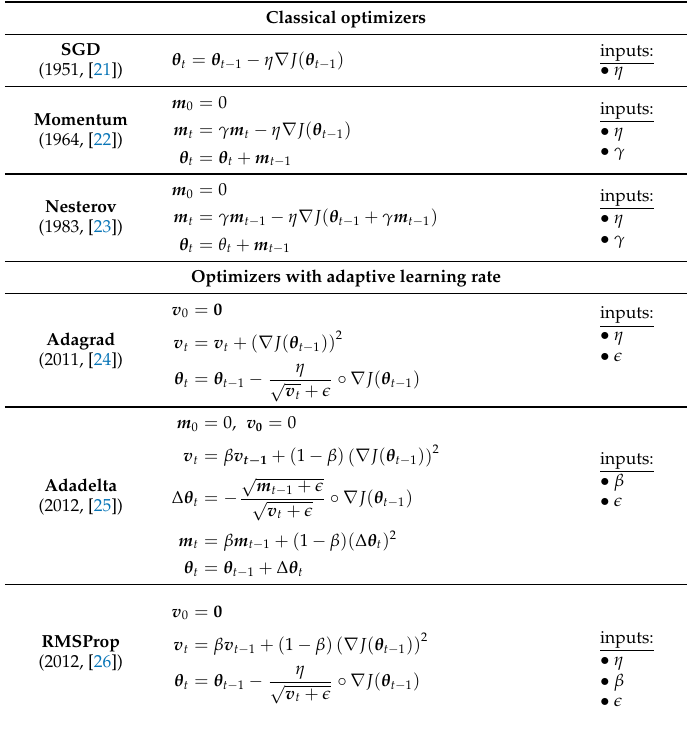
Table A1. Summary of the update rules of